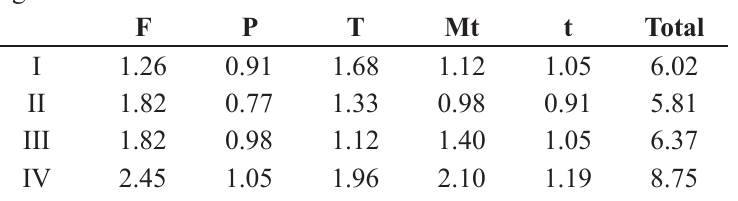
Palp: claw with three teeth, turned inward over 45°. Tarsus provided with strong retrolateral spines. Epigyne (Figs 9C, 10D): dark, fairly large central depression longitudinal, separated from posterior margin by transverse rectangular